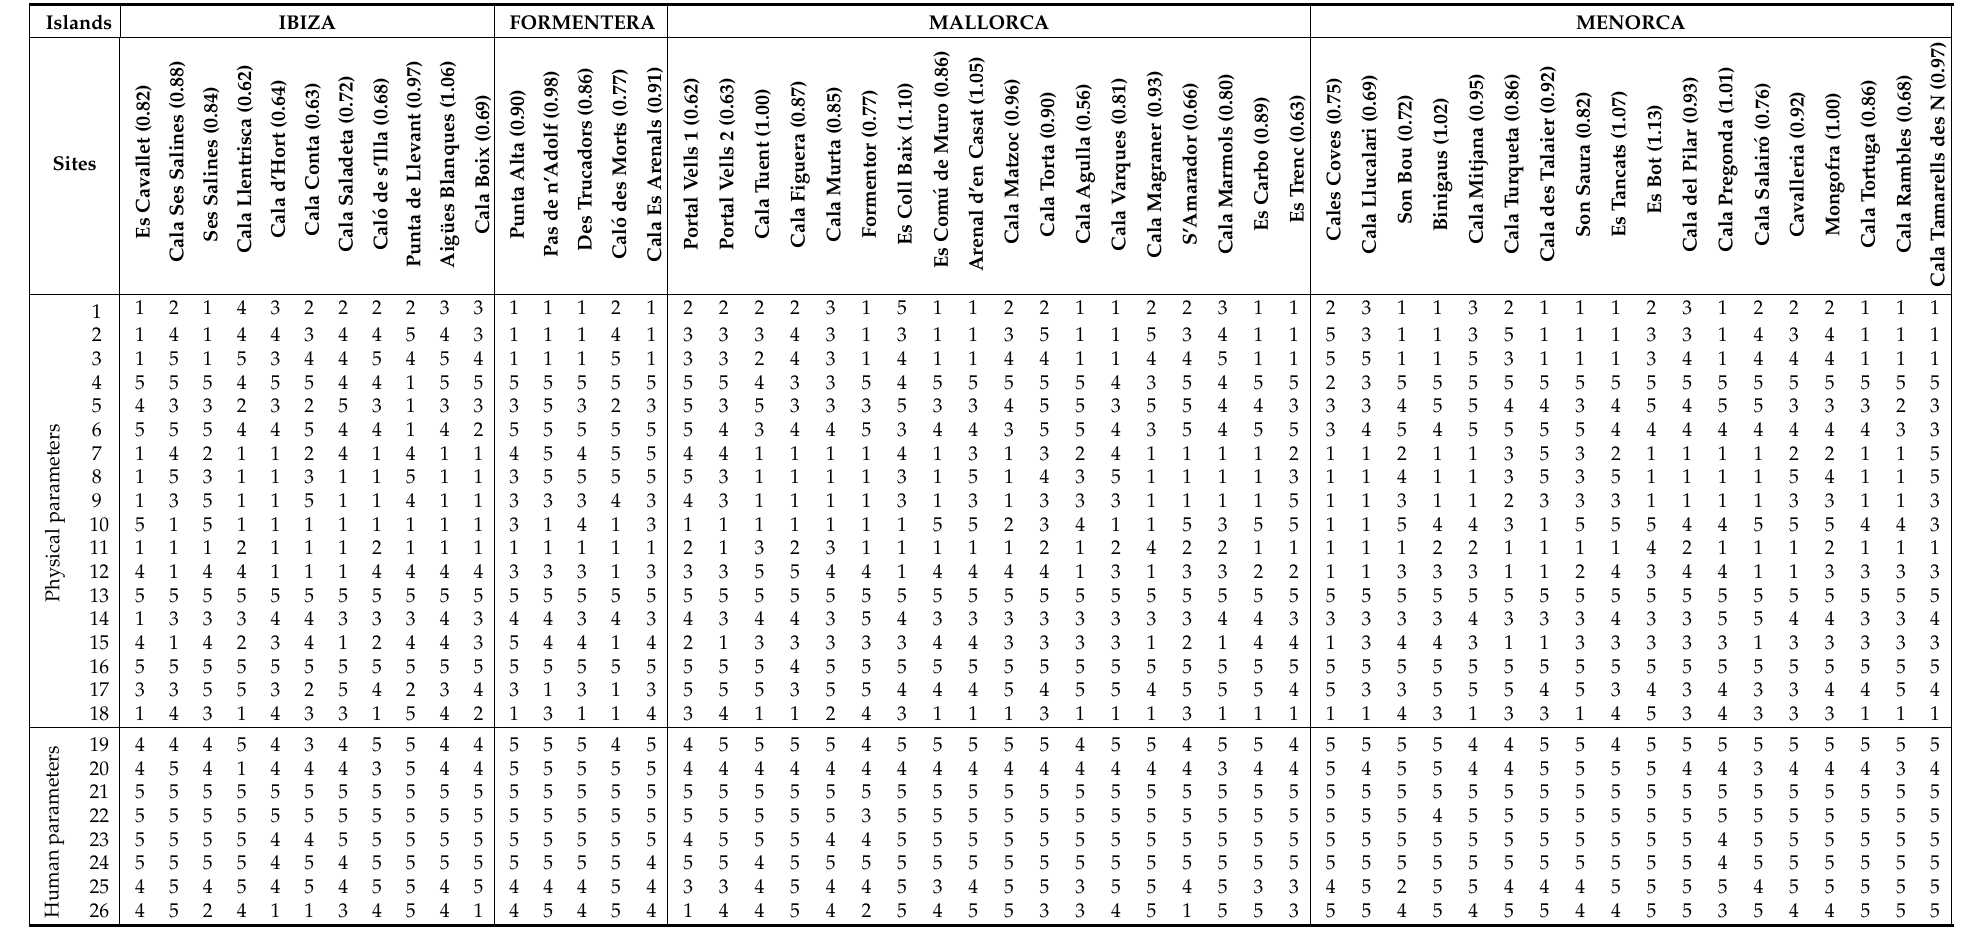
Table A2. Natural and human parameters ratings at the 52 sites